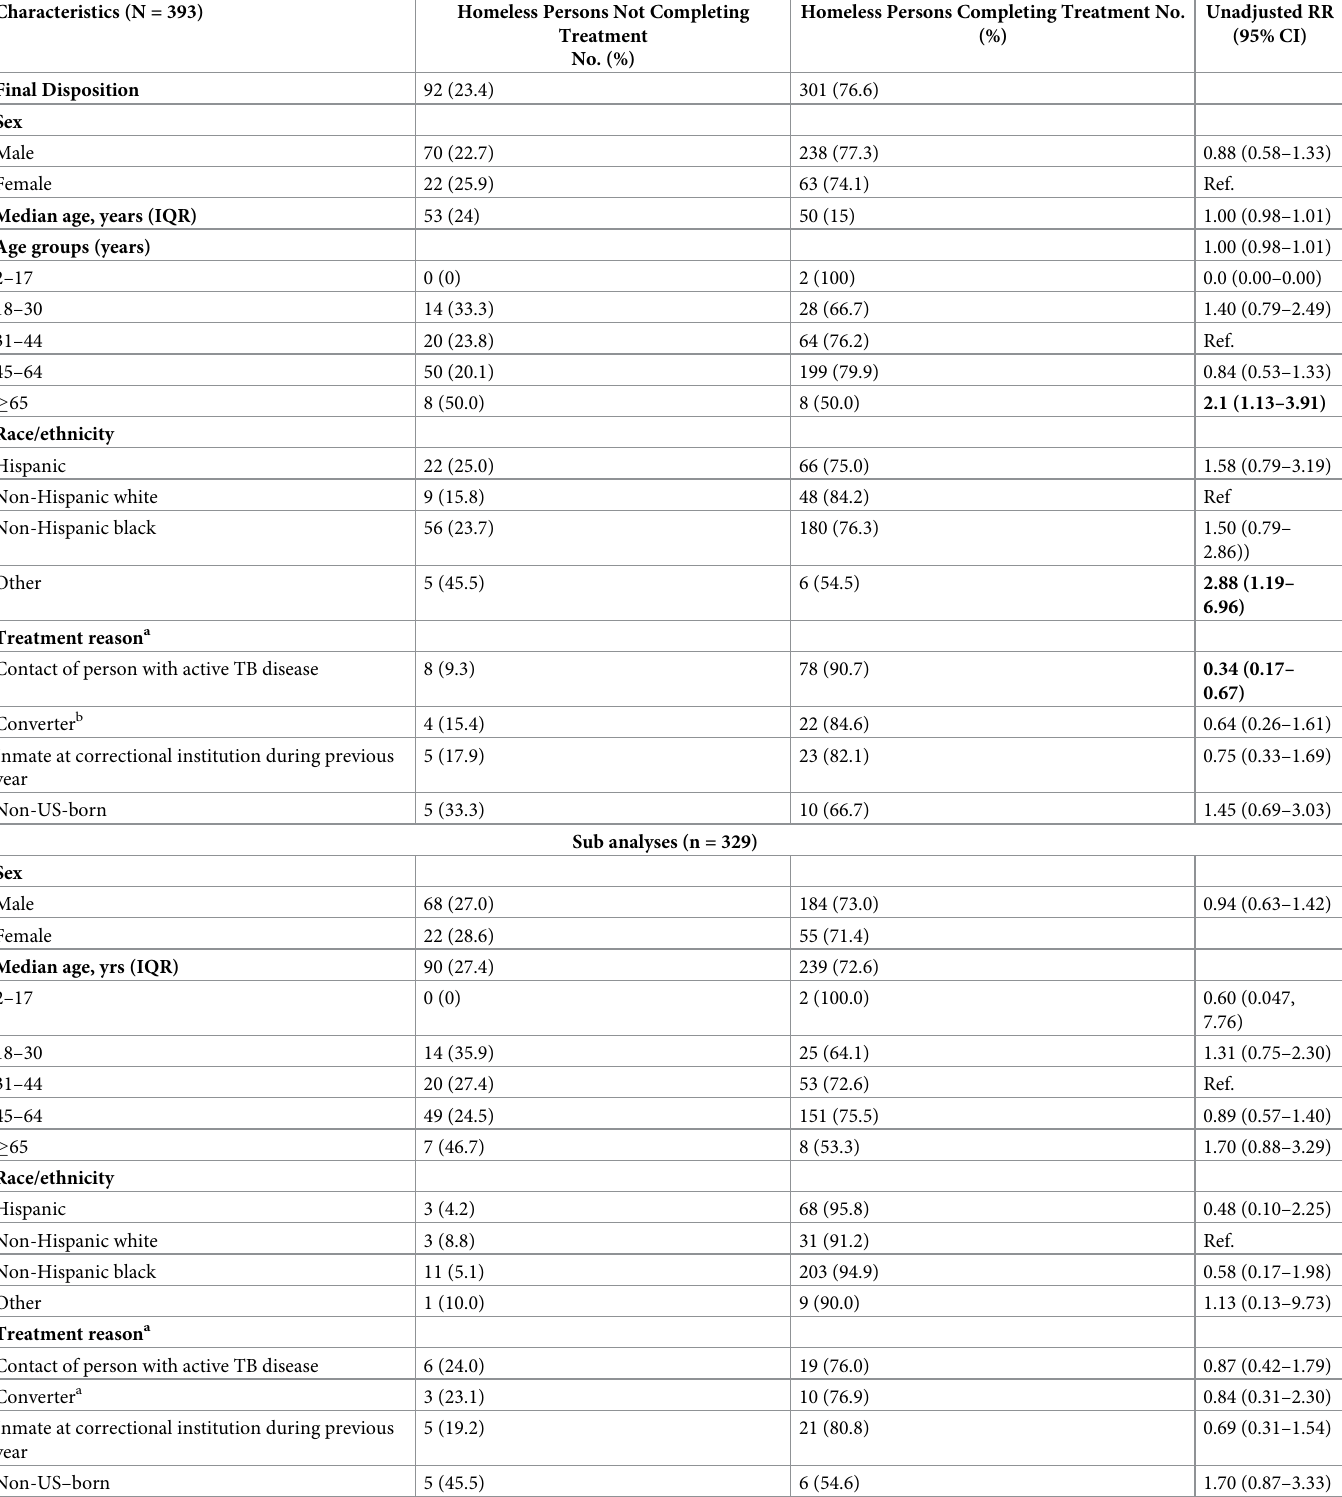
Table 3. Characteristics associated with treatment discontinuation among persons experiencing homelessness in 11 US sites from July 2011- June 2015. Characteristics (N =